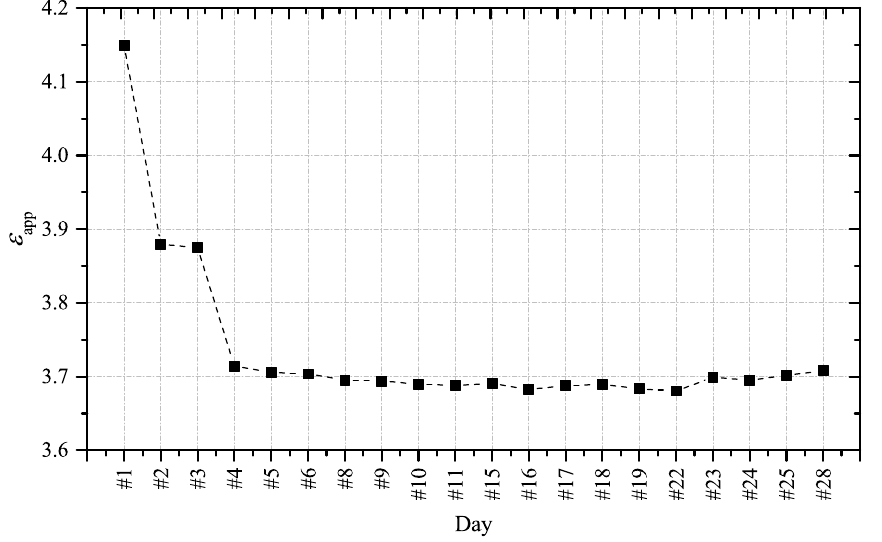
Figure 12. Trend of ε app during the hydration process.